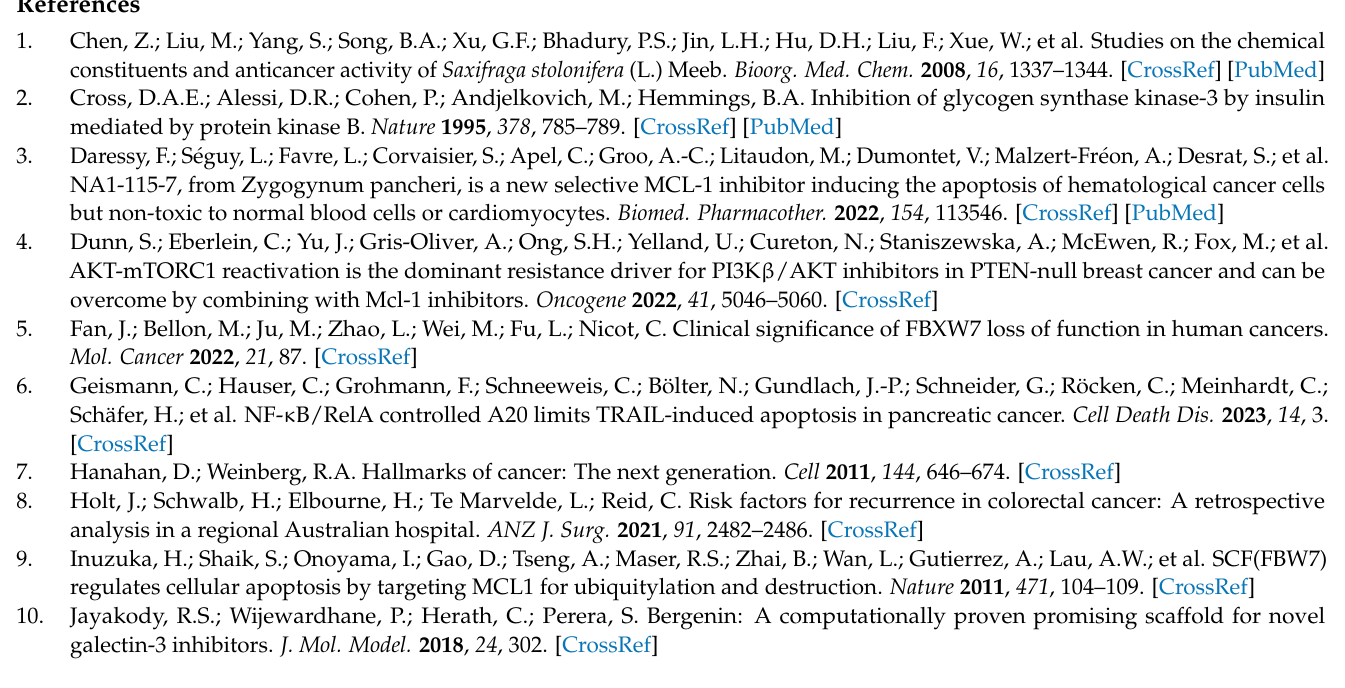
Supplementary figure for result 2.3; Figure S3: Supplementary figure for result 2.6; Figure S4: Full gel for